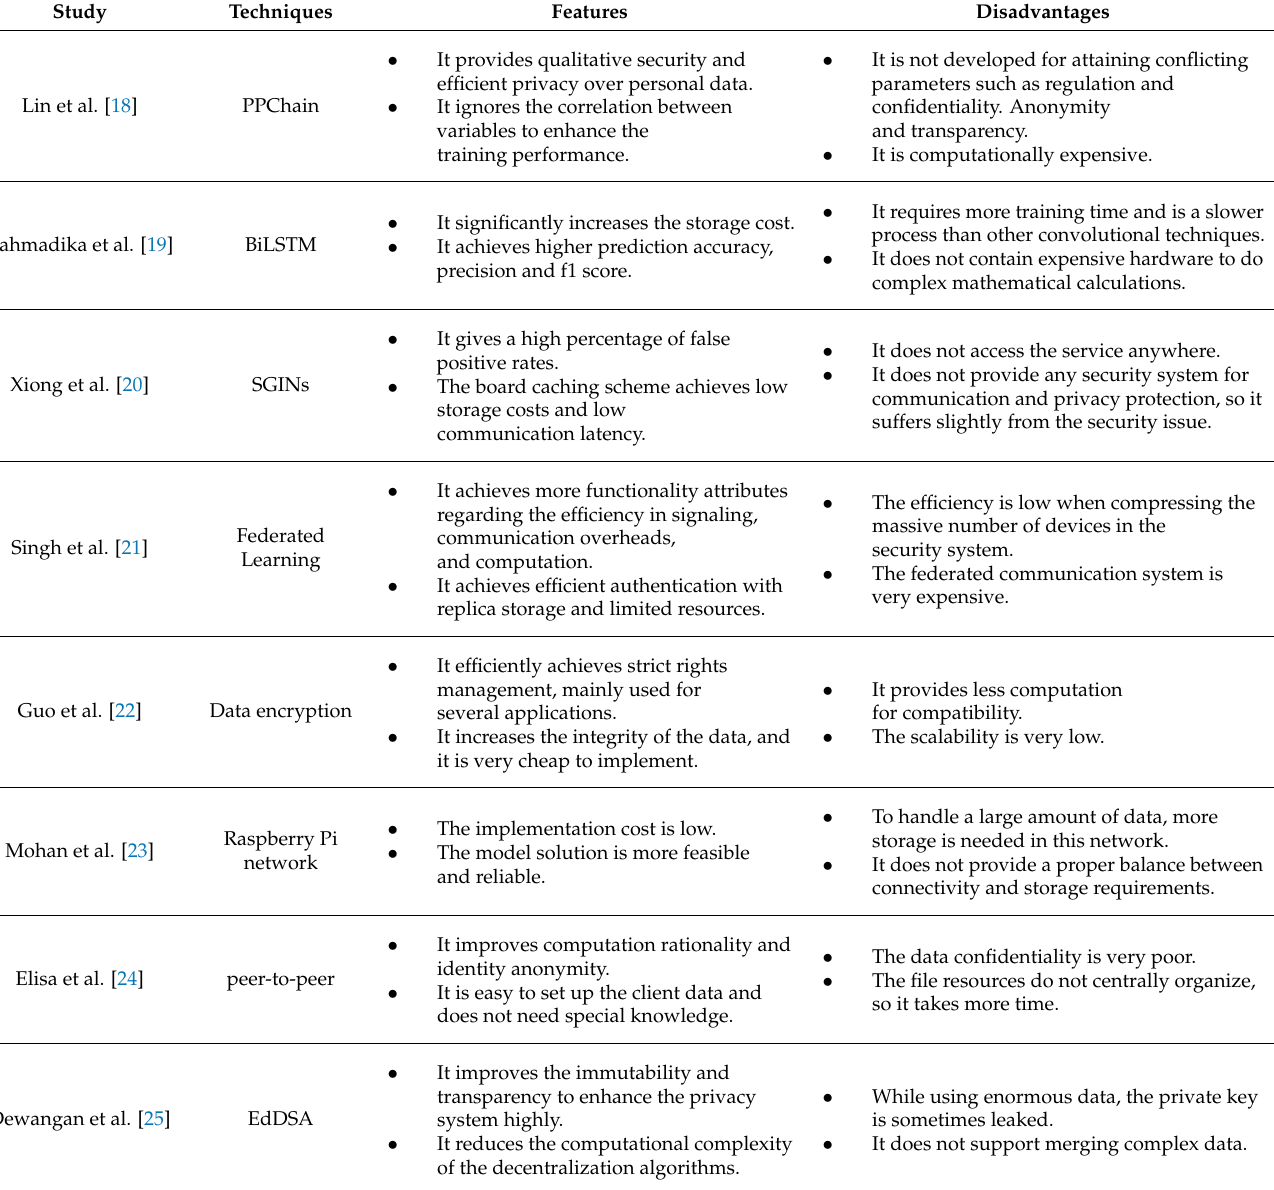
Table 1. Features and disadvantages of the existing blockchain-based privacy preservation techniques with blockchain technology in